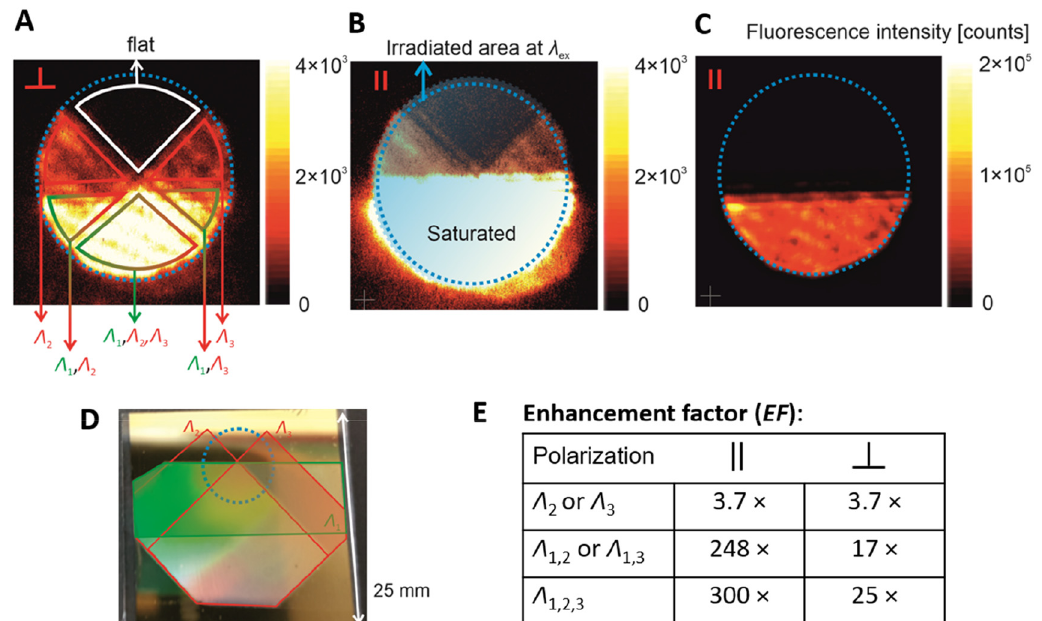
Figure 5: Experimentally determined fluorescence enhancement factors. Fluorescence images taken from an area, where different combinations of spatial MPG componentsare present.Polarization of the excitation beam was (A) orthogonal and (B,C) parallel to the grating Λ 1 . (D) Photograph of the prepared MPG with highlighted areas carrying different spectral components of MPG and (E) comparison of the respective enhancement factors with respect to that measured for the fl at